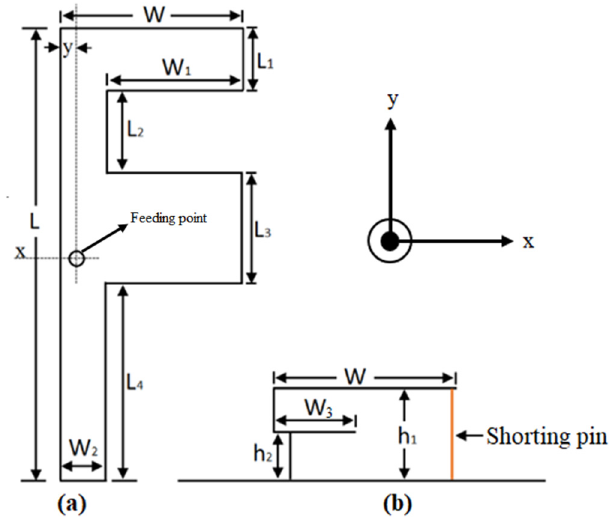
Figure 1. Proposed antenna: ( a ) top view and ( b ) side view. Table 1. Optimal parameters of the proposed antenna.